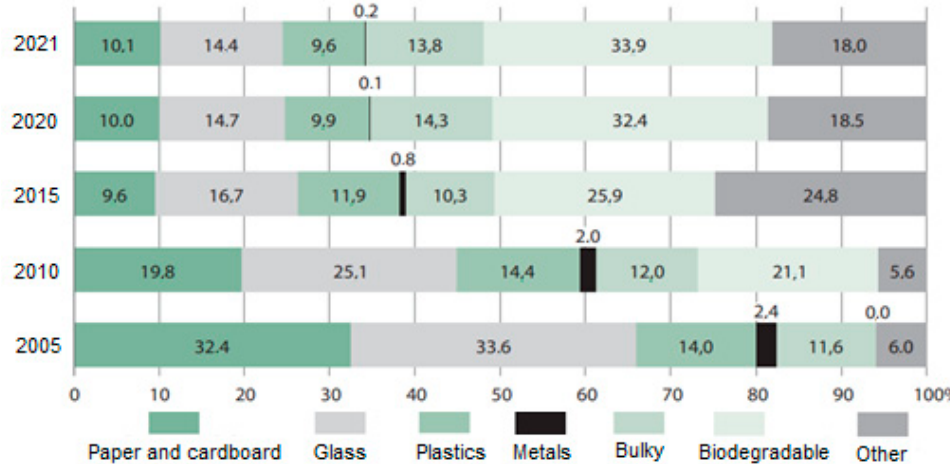
Figure 5. Structure of separately collected municipal waste by waste fraction. Source: Environmental Protection 2022, CSO, Warsaw, 2022.